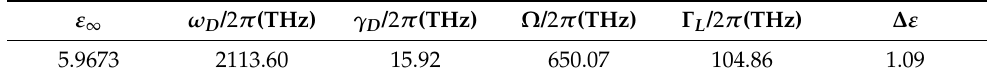
Table 2. The parameters of